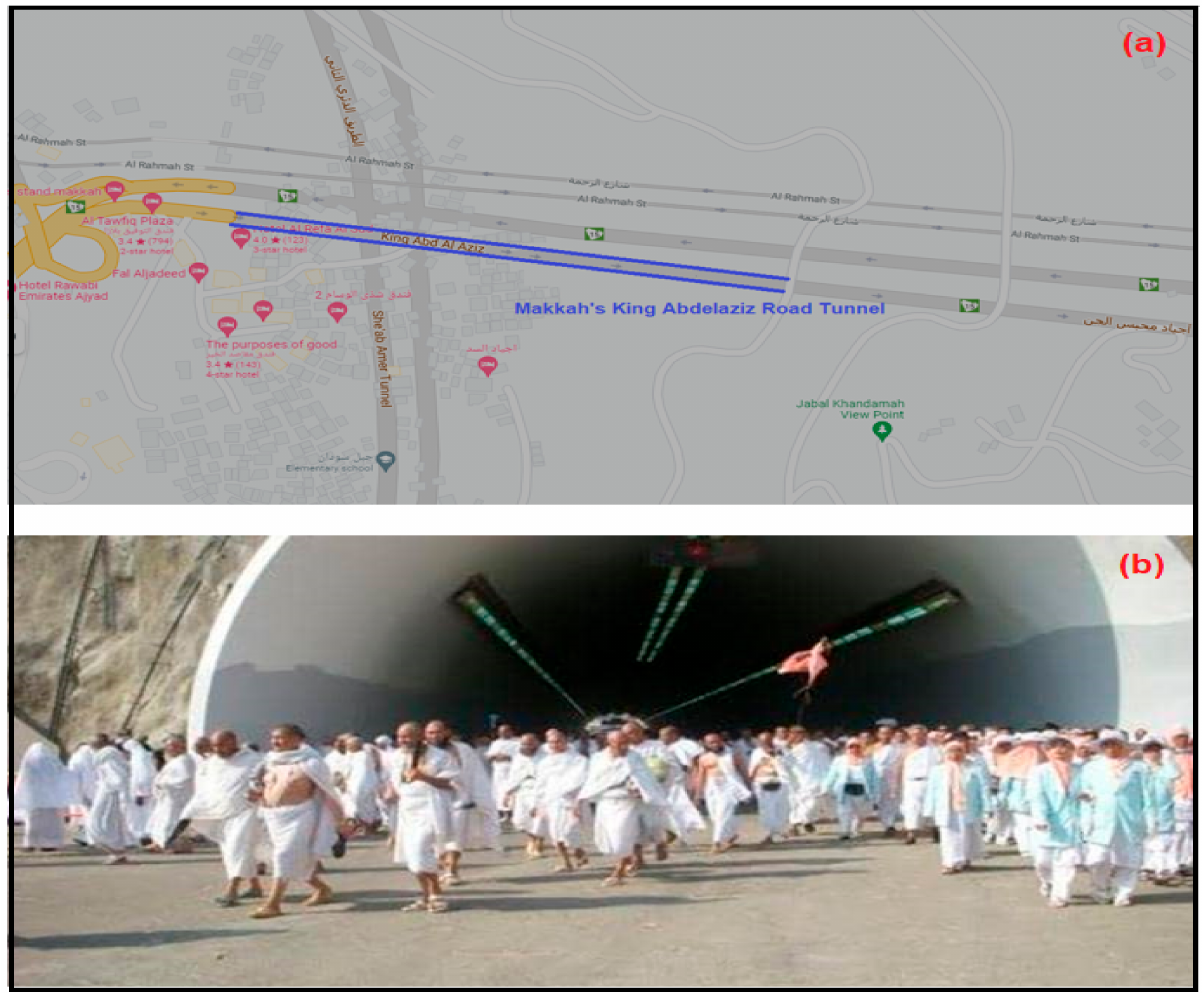
Figure 7. Makkah’s King Abdelaziz Road Tunnel: ( a ) location and ( b ) its dense crowd during Hajj